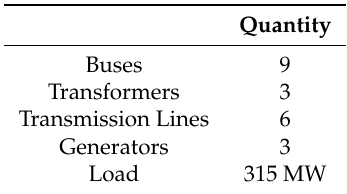
Table 3. Elements of the IEEE 9 bus